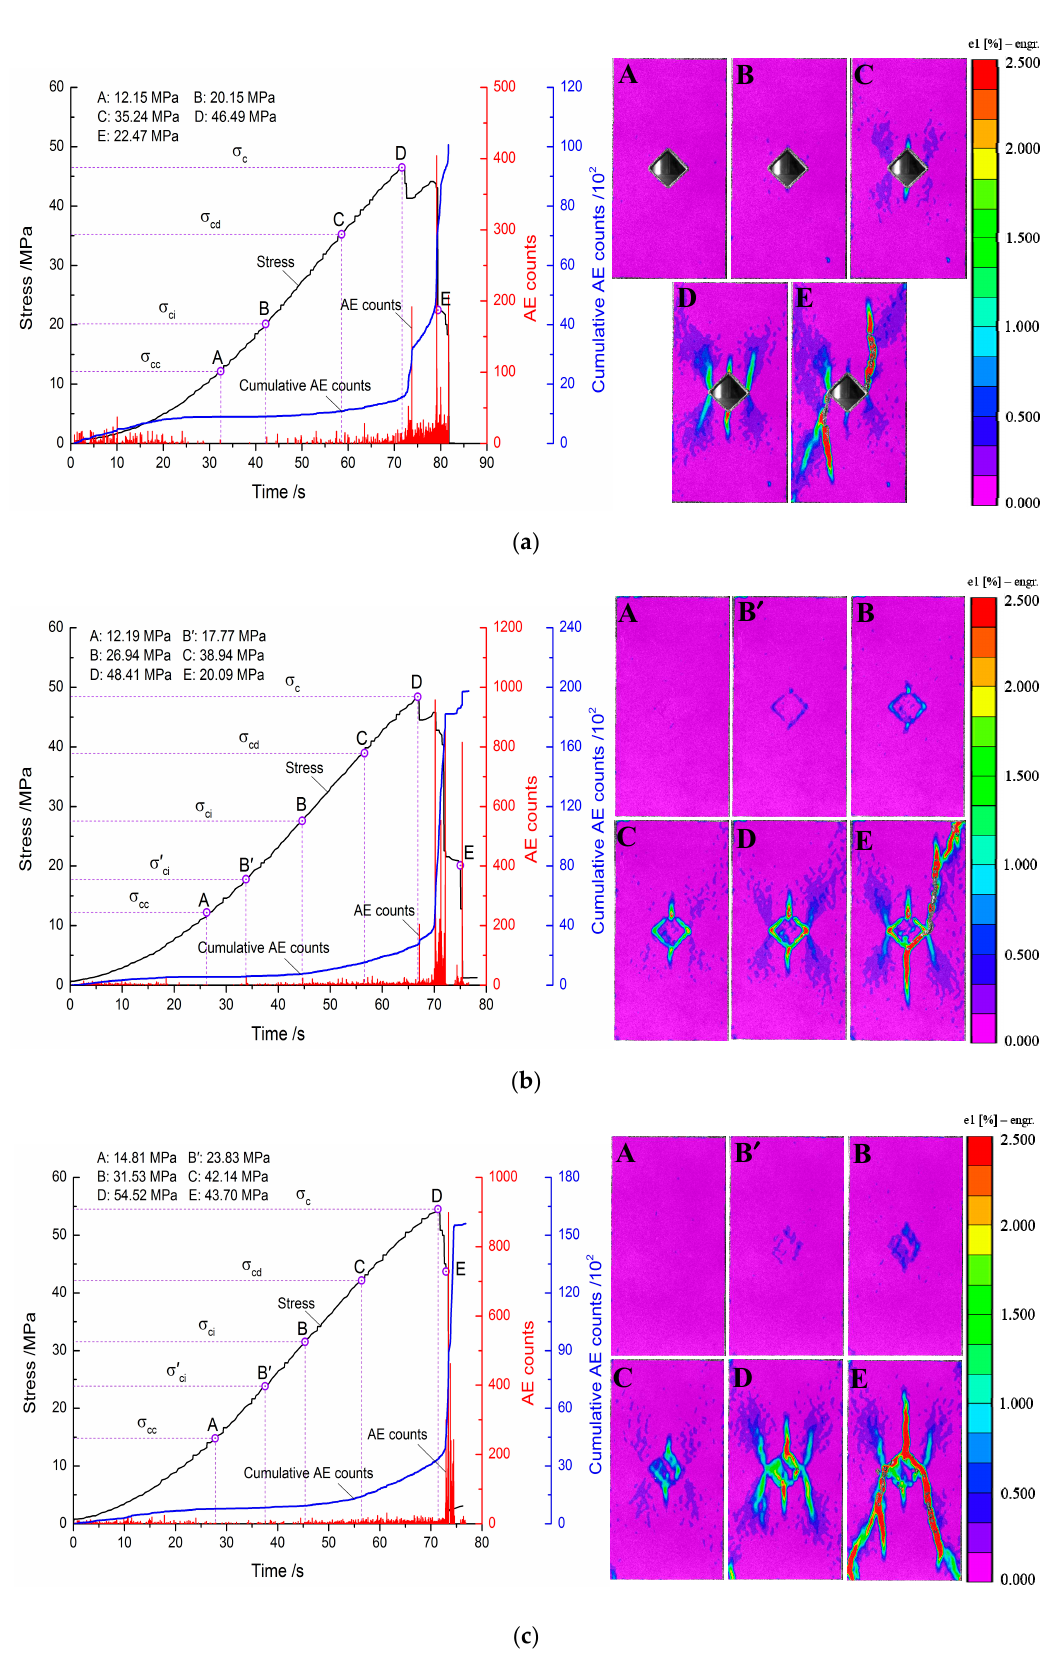
Figure 10. AE behavior and strain fields of pre-holed specimens with α = 45° under different filling modes: ( a ) Sq-45-A-1; ( b ) Sq-45-B-2; and ( c ) Sq-45-C-1.